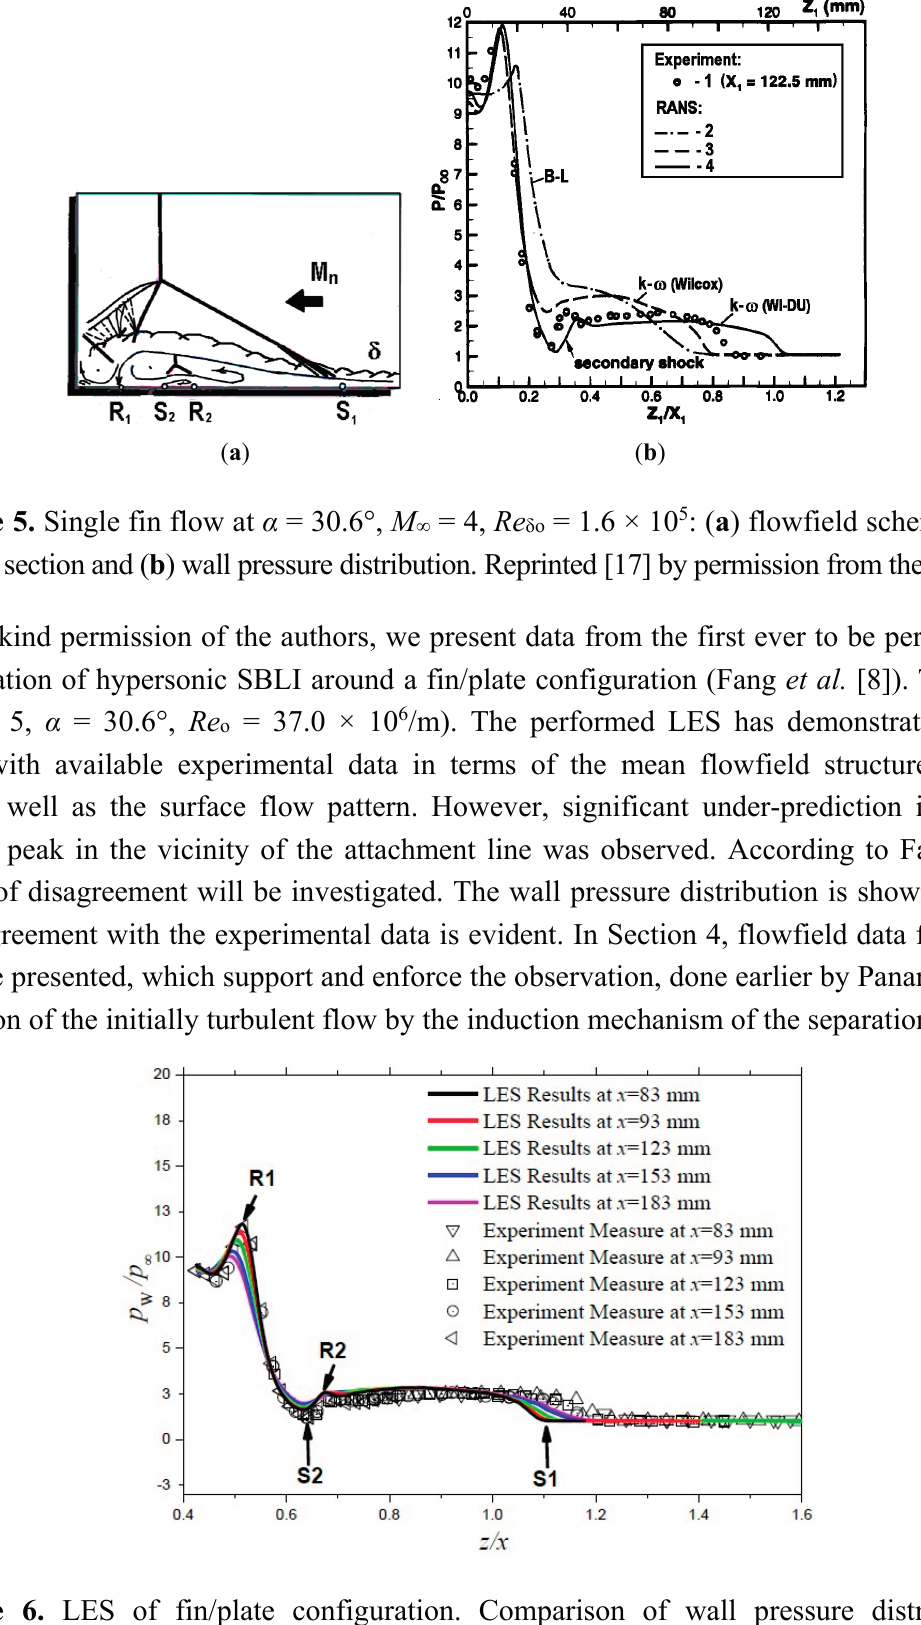
Figure 6. LES of fin/plate configuration. Comparison of wall pressure distribution. Reprinted [8] by permission from the